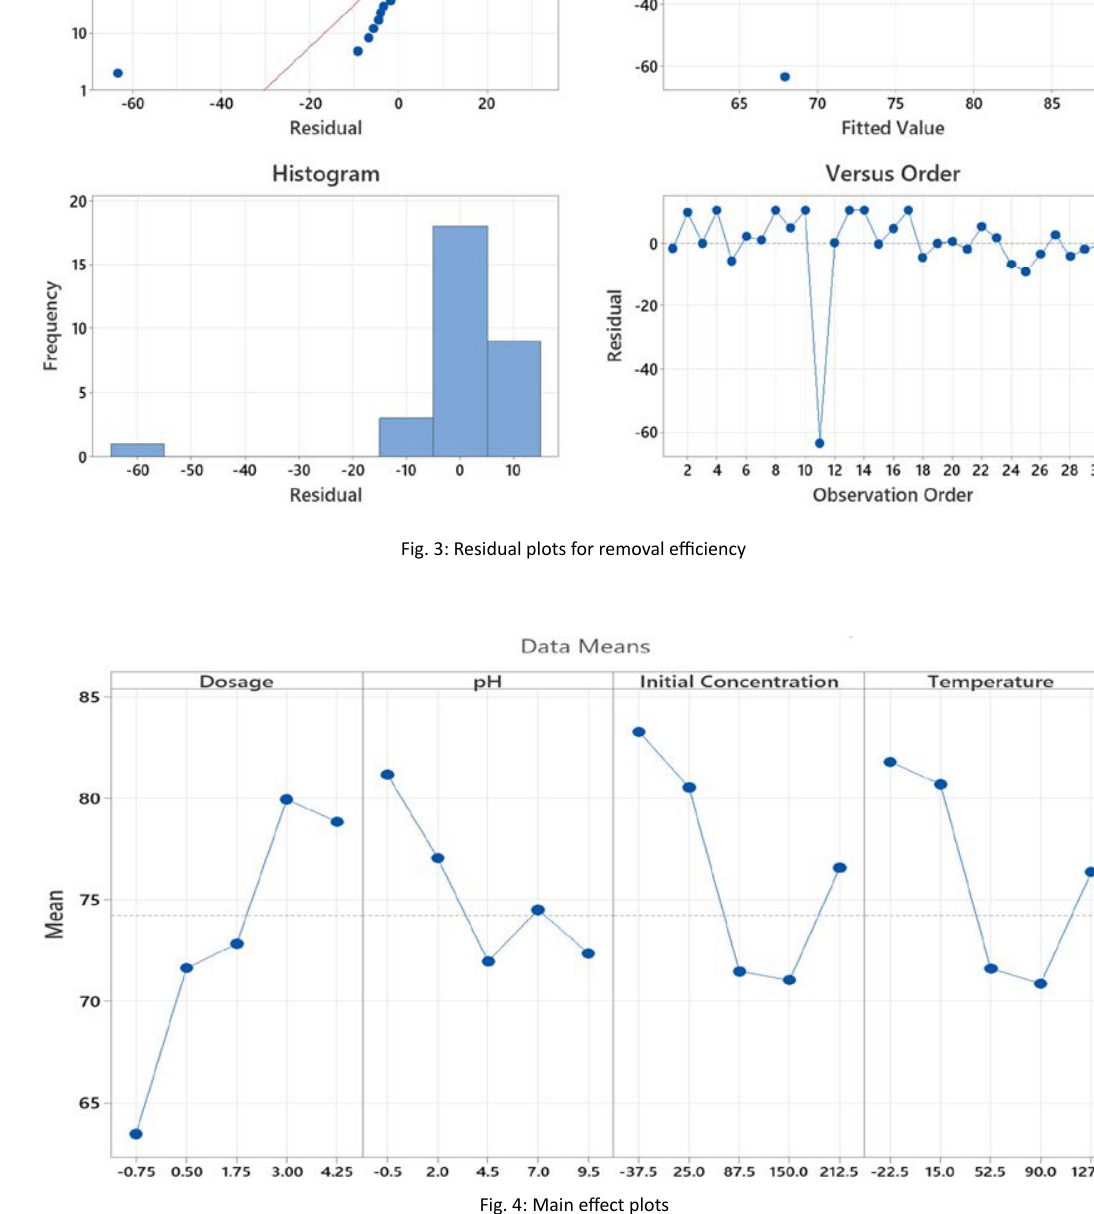
Fig. 4: Main effect plots